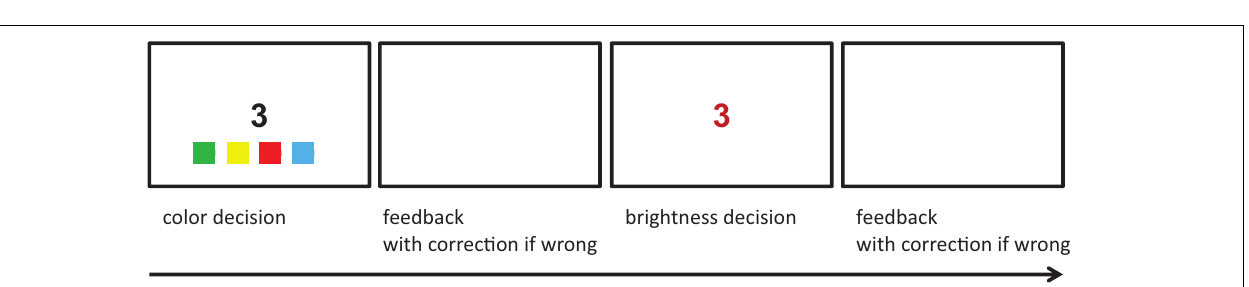
FIGURE 5 | Adaptive training. Exemplary depiction of a trial. Adopted from Rothen et al. (2011).